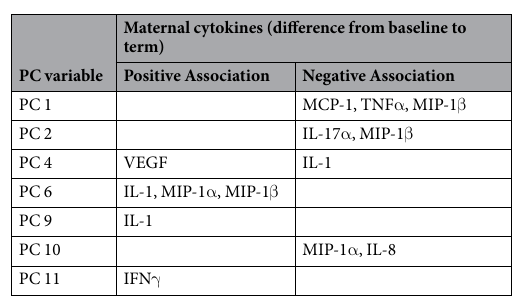
Table 7. Change in association of EDC mixtures with maternal cytokines from first trimester to term.